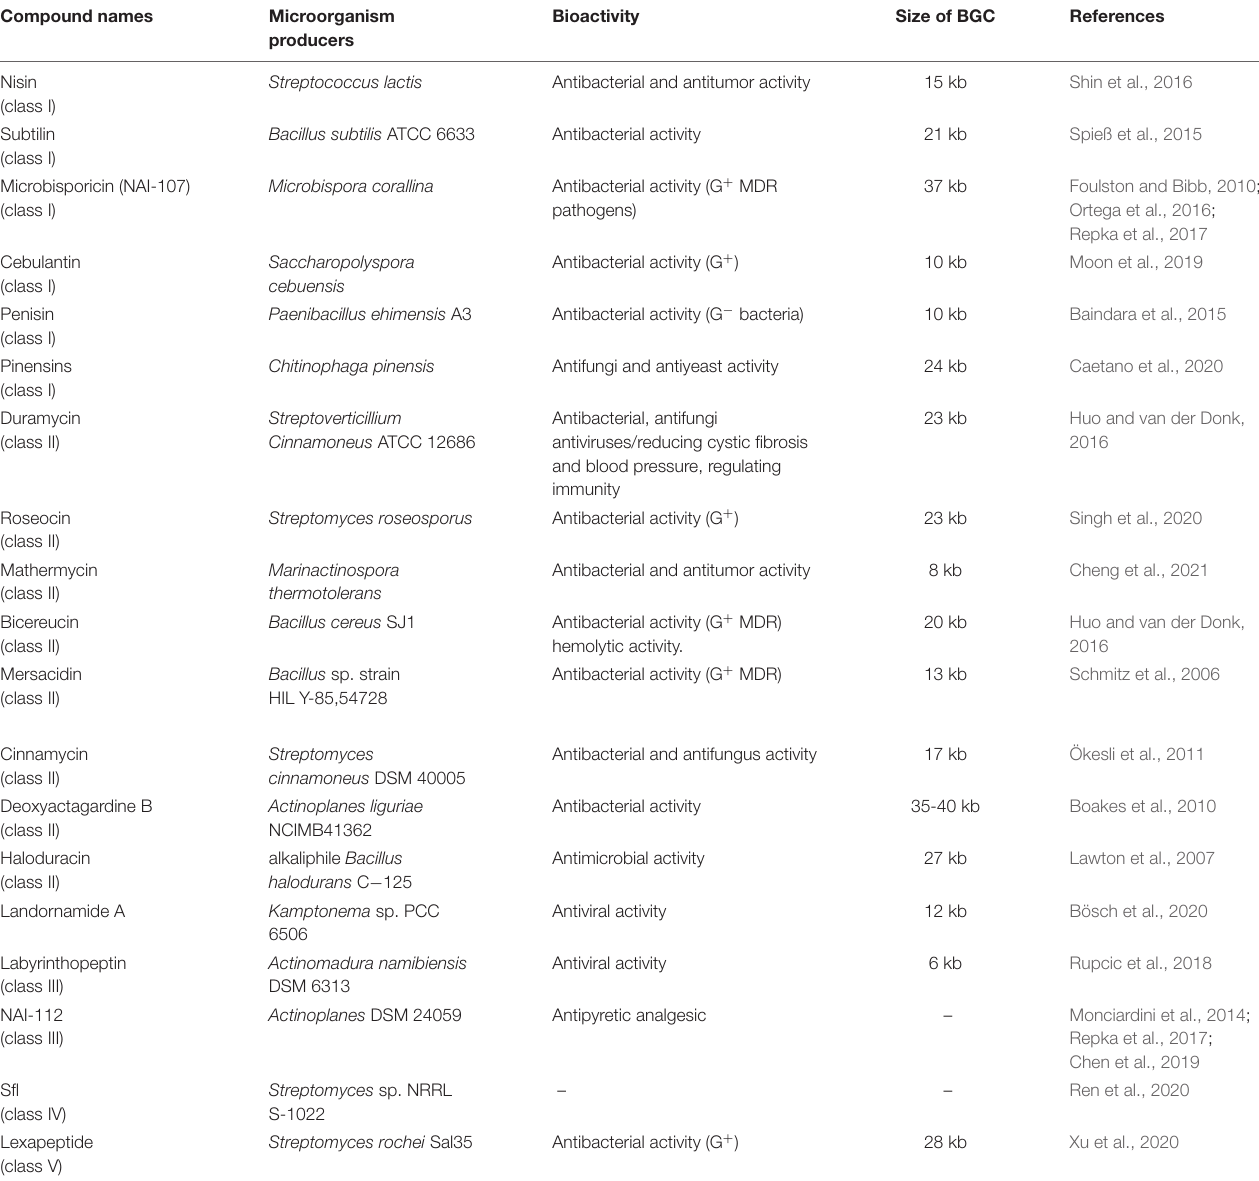
TABLE 1 | Producers, bioactivity and BGCs of representative lanthipeptides.